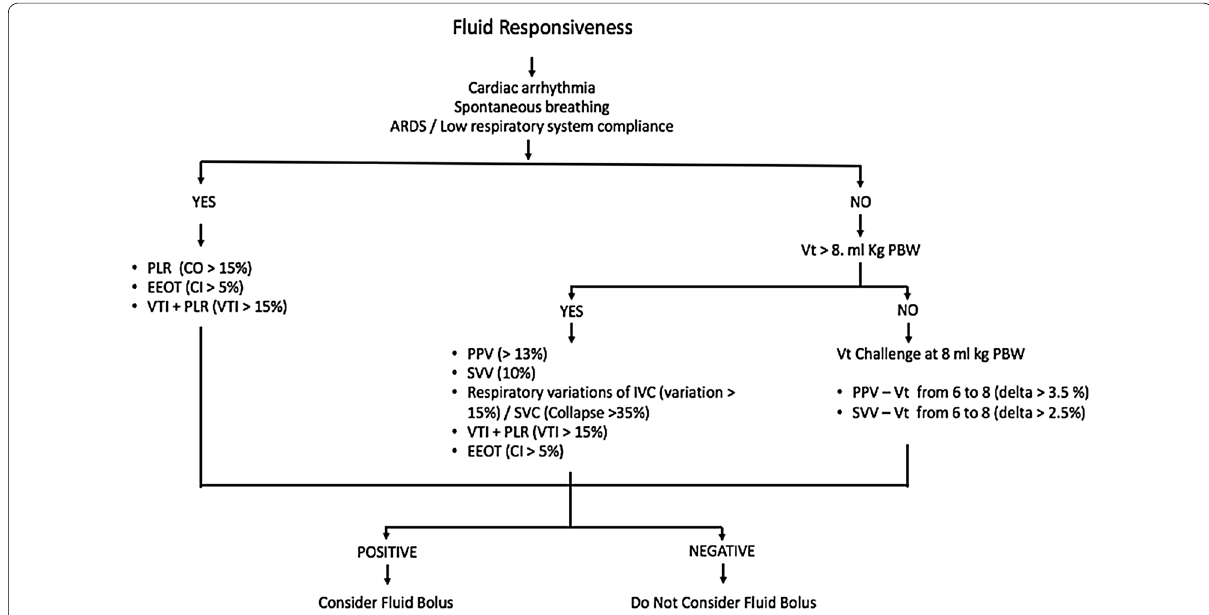
Fig. 3 Assessment of fluid responsiveness during the study period. The figure describes an algorithm for assessing fluid responsiveness in different settings depending on the presence or not of mechanical ventilation, arrhythmias or other conditions. Different tests are proposed with the respec‑ tive cutoff values. ARDS acute respiratory distress syndrome; PLR passive leg rising; CO cardiac output; EEOT end‑expiratory occlusion test; CI